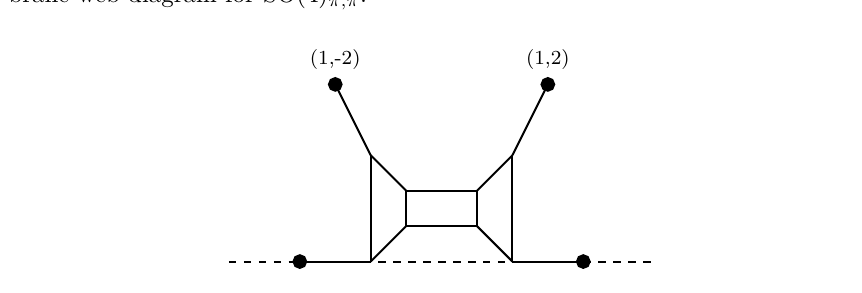
Figure 13. Left: the web diagram for SO(4) gauge theory with 1 s + 1 c with negative large masses. Right: 5-brane web diagram for SO(4) π,π .